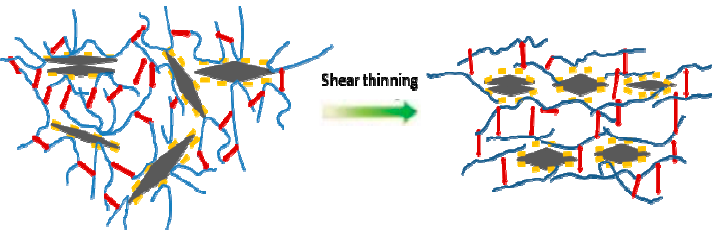
Figure 6. Viscosity curve of composite gels at different bentonite concentrations.